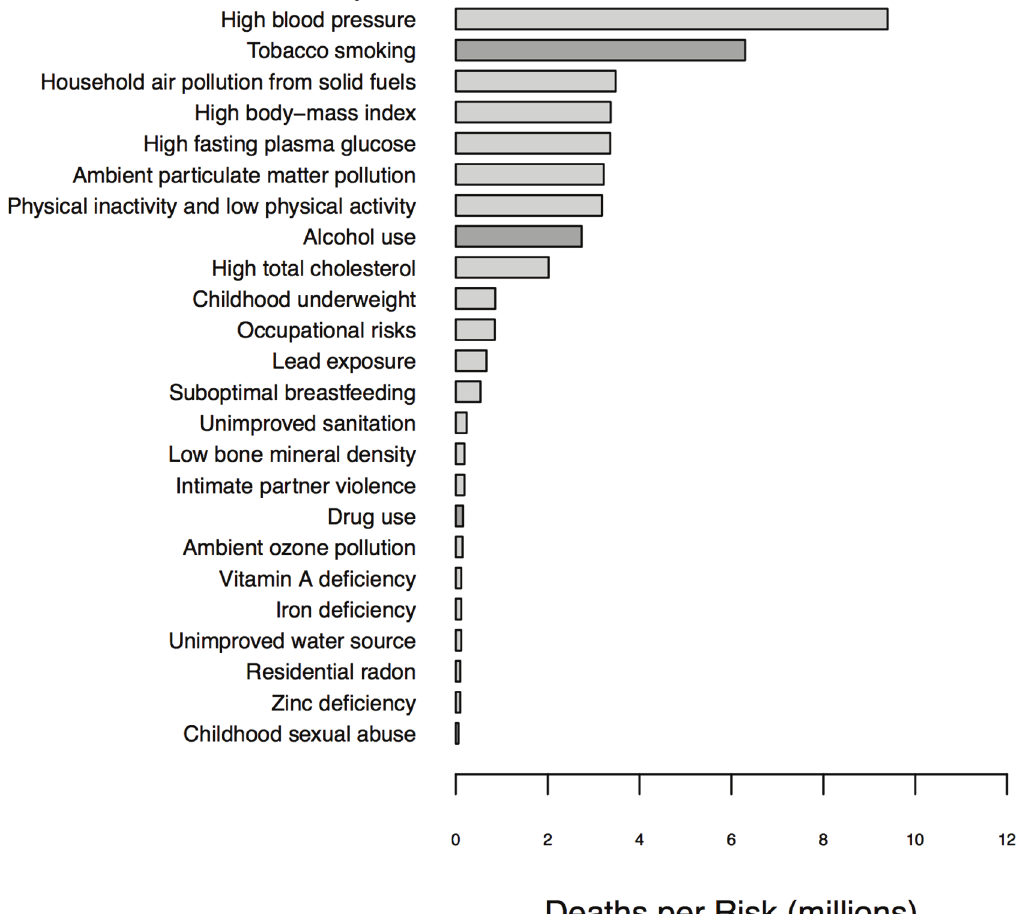
Figure 2. Global deaths annually by risk